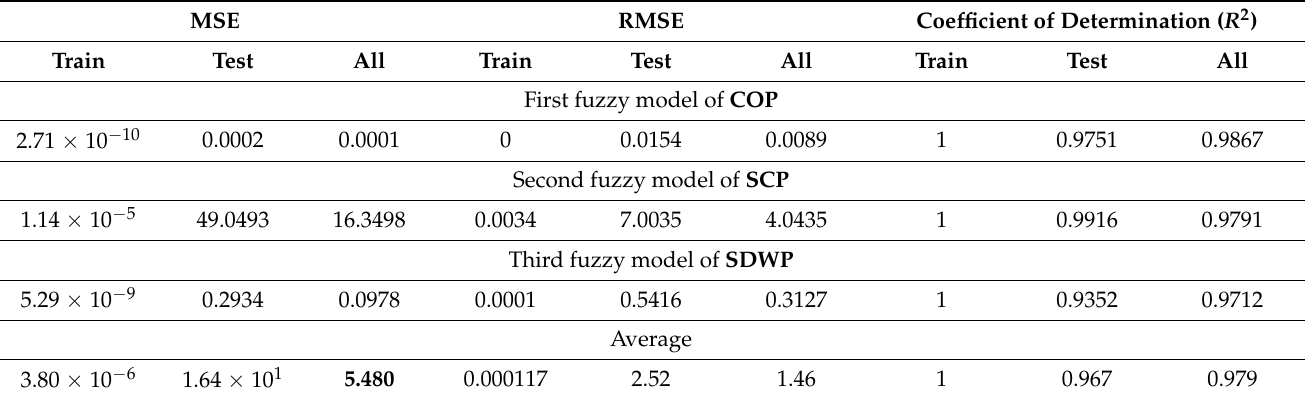
Table 5. Statistical assessment of the ANFIS models of COP, SCP, and SDWP.